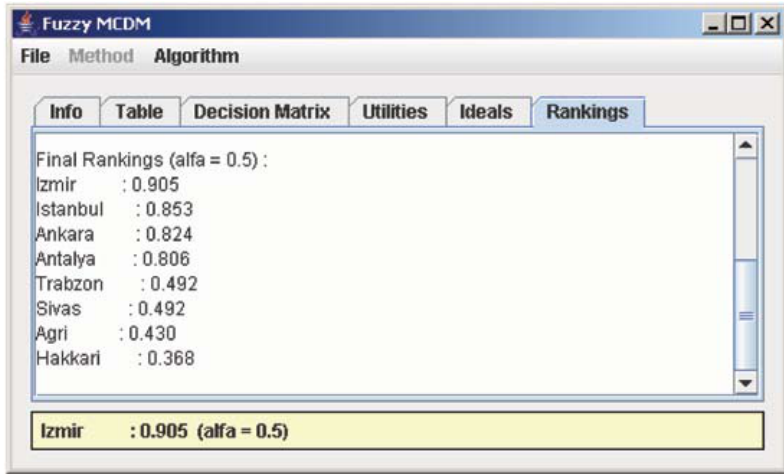
Fig. 6. Result of the staff assignment